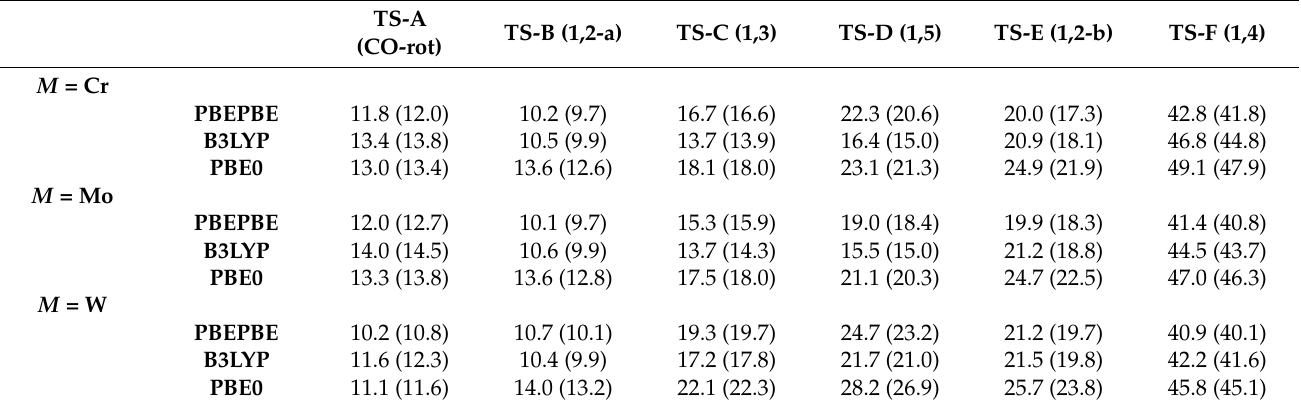
Table 1. Computed relative electronic energies and free energies (in parentheses) for (TMCOT) M (CO) 3 ( M = Cr, Mo, W) fluxional transition states with DFT/BS1 (all energies reported in kcal mol − 1